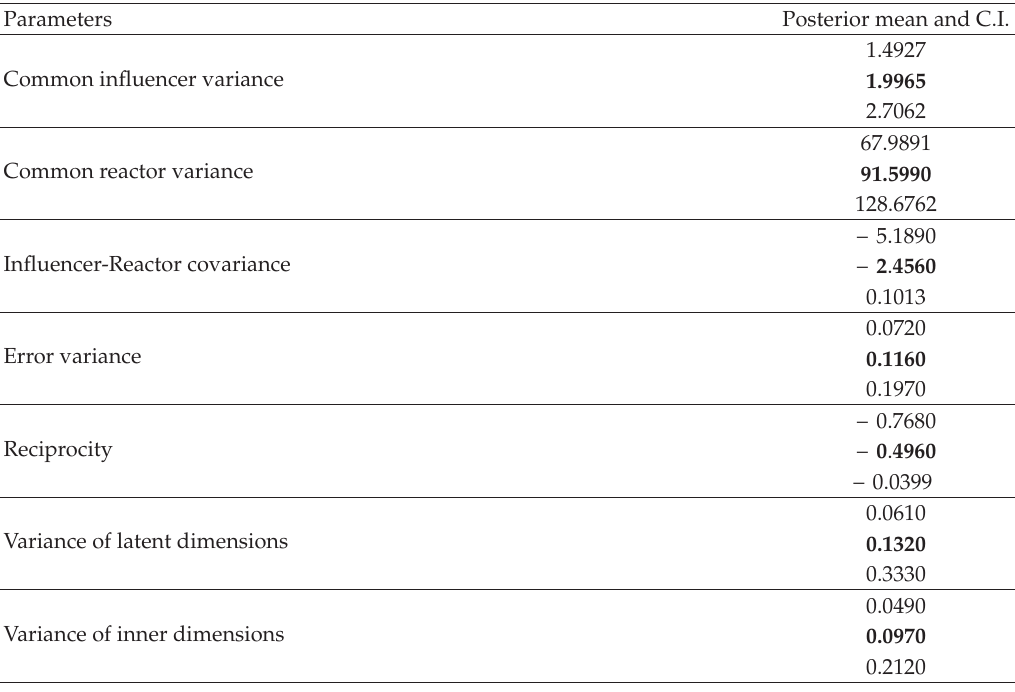
Table 4: Posterior means and quantile-based 95% confidence interval for major parameters of the bilinear- e ff ects